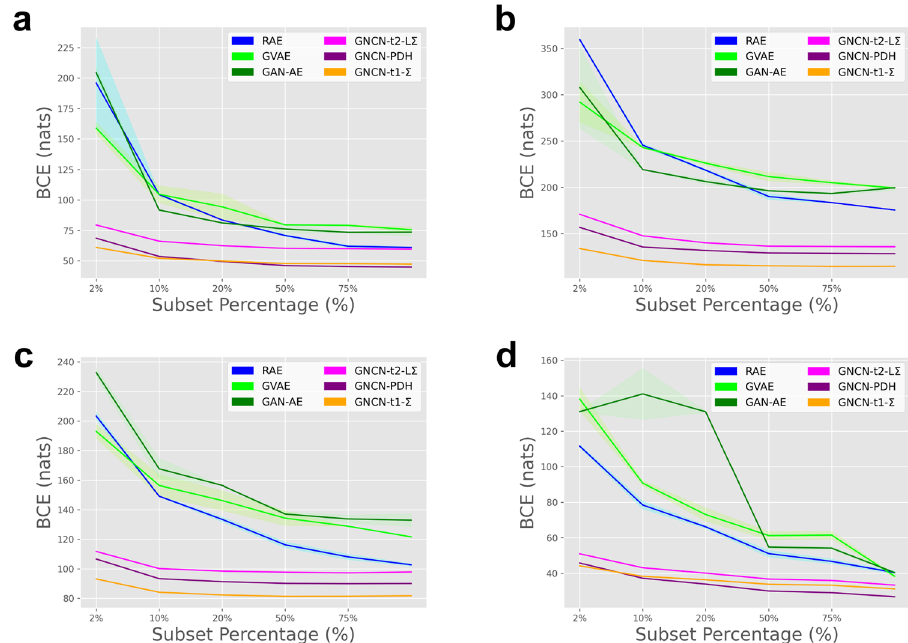
Fig. 4 Data ef fi ciency measurements. Test BCE loss measurements (lower is better) for pattern reconstruction on data subsets (measured in terms of percentage % of the original database sampled, with data points being extracted randomly without replacement) of increasing size for a MNIST, b KMNIST, c FMNIST, and d CalTech. Curves depict the mean (solid line) and the standard deviation (lighter-colored envelope) over 10 trials. Plotted are the resulting curves for three backprop-based autoencoder models, i.e., RAE, GVAE, and GAN-AE, and three neural generative coding models, i.e., GNCN- t2-L Σ , GNCN-PDH, and GNCN-t1- Σ . (Note that GNCN-t1- Σ is also referred to as GNCN-t1- Σ